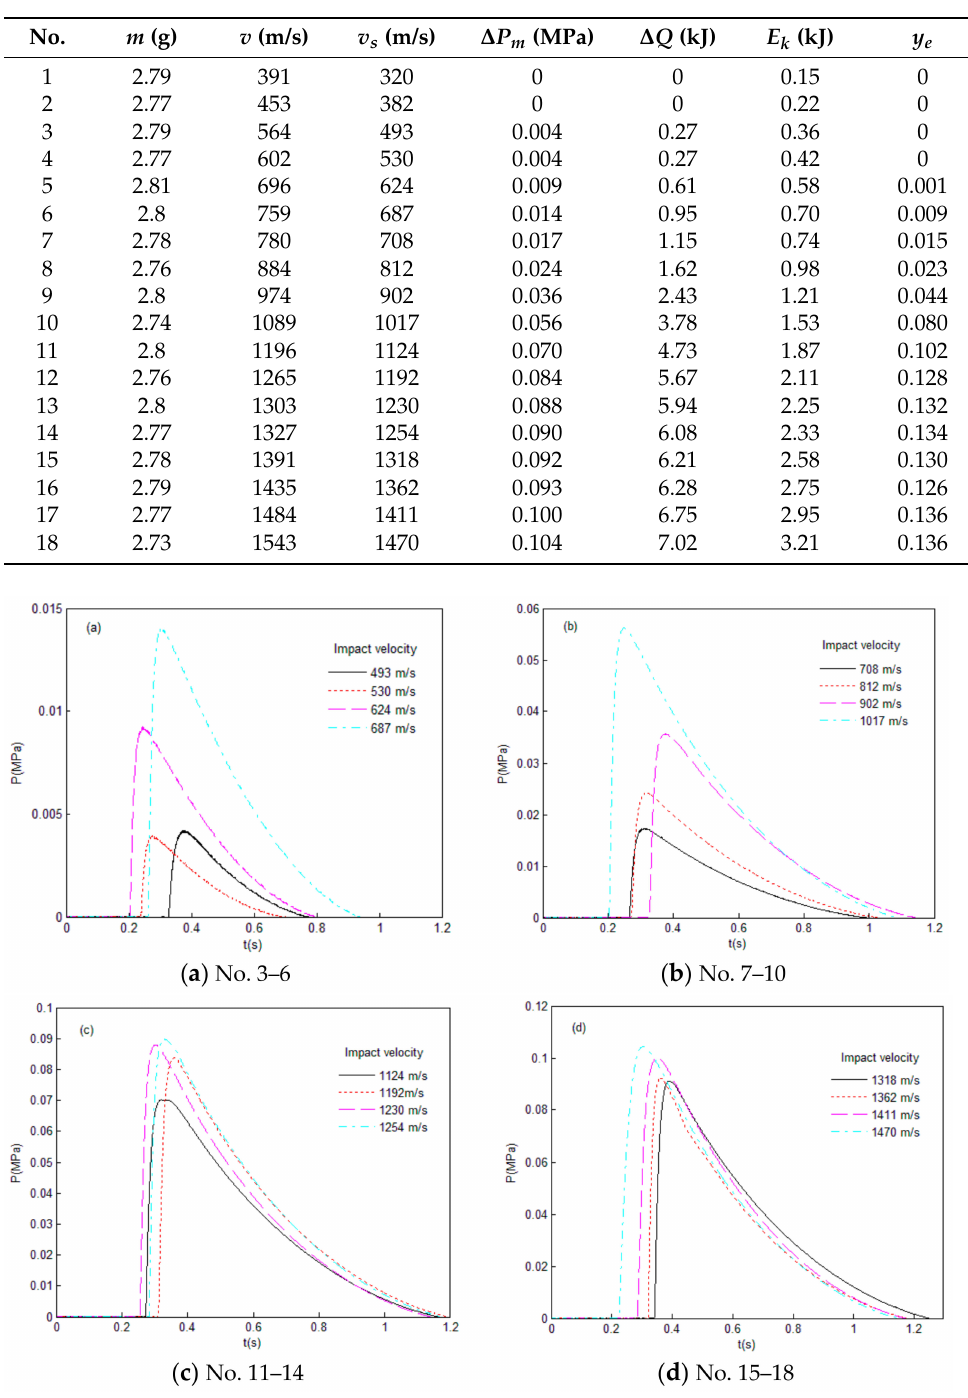
Figure 6. The test pressure–time curves for fragments with different impact